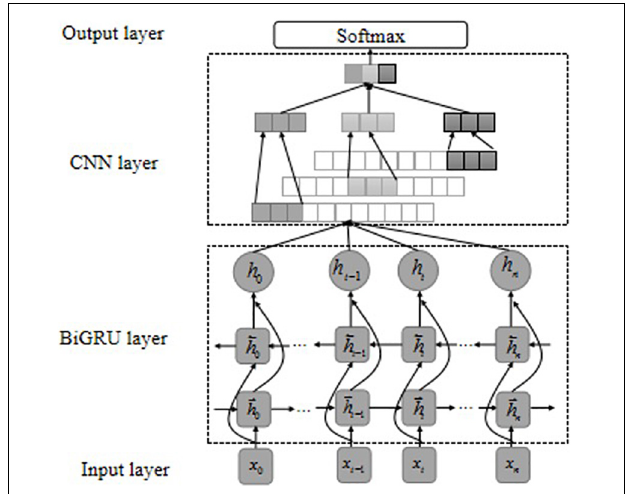
FIGURE 5 | Hybrid BiGRU-CNN model structure.